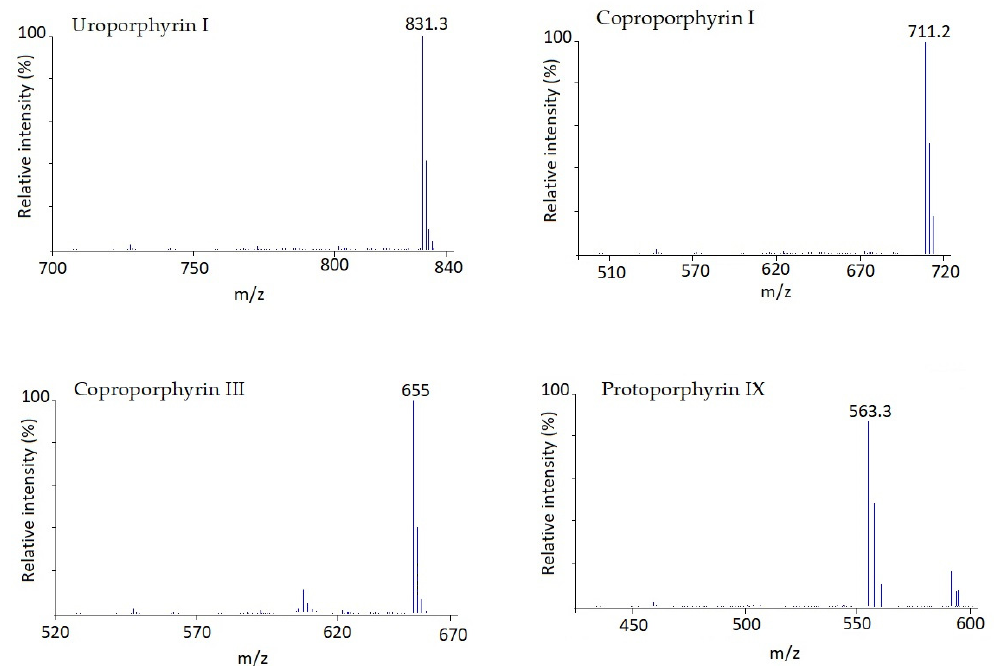
Figure 3. Ion spectrum of Uroporphyrin I, Coproporphyrin I, Coproporphyrin III and Protoporphyrin IX.